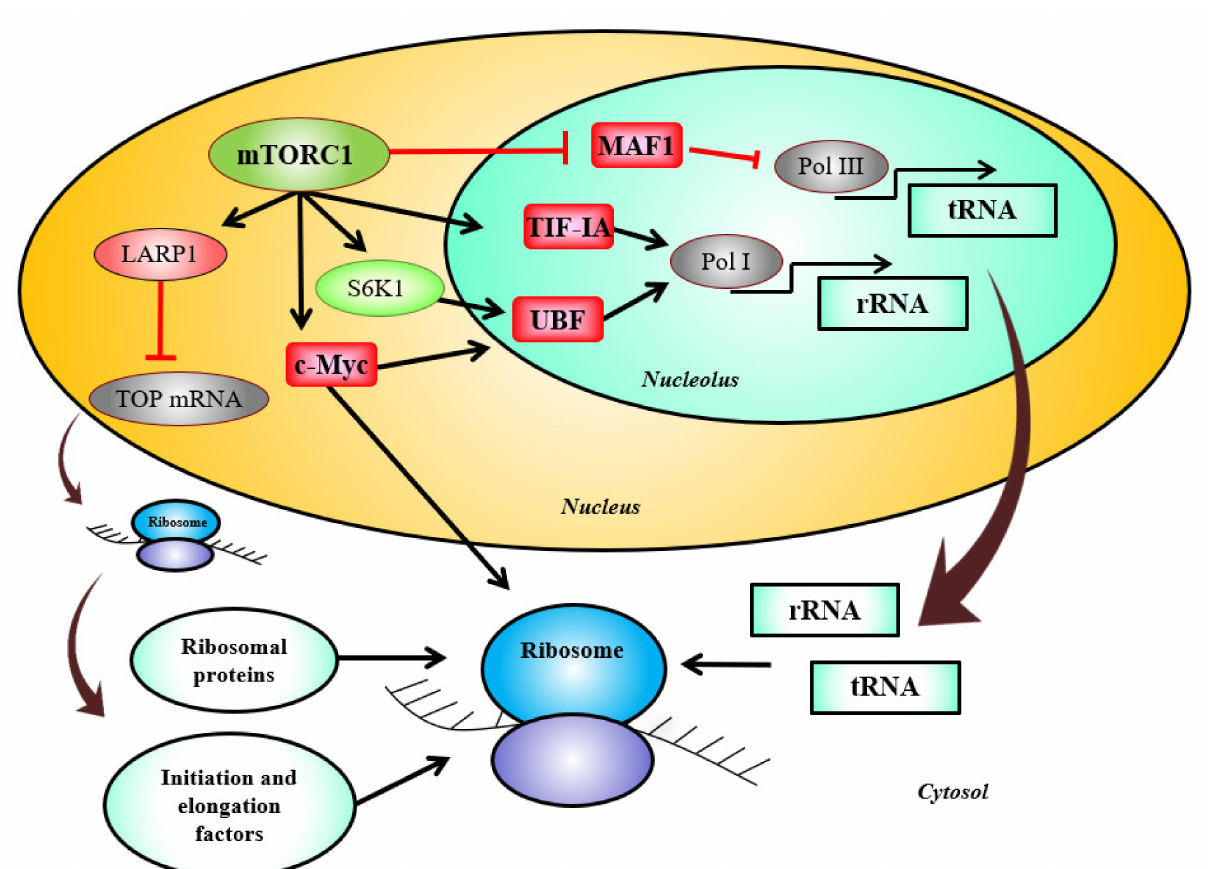
Figure 2. mTORC1 stimulates ribosome biogenesis. mTOR (mechanistic/mammalian target of rapamycin) modulates the activity of TIF-1A(transcription initiation factor IA) involved in pre-ribosomal RNA synthesis and of the ubiquitous transcription factor c-Myc that controls genes products involved in the transcription and processing of rRNA, in the protein components synthesis, and in the nuclear export of ribosomal subunits. mTOR phosphorylates MAF1 leading to inhibition of RNA Pol III (RNA polymerase III) repression function, allowing transfer RNA (tRNA) synthesis. mTORC1 (mechanistic/mammalian target of rapamycin complex 1) interacts with the RNA binding protein LARP1 (La-related protein 1), involved in TOP (terminal oligopyrimidine) mRNAs translation, and subsequently regulates the production of ribosomal proteins and initiation and elongation factors. S6K1 (S6 kinase 1), a master substrate of mTORC1, stimulates RNA Pol I (RNA polymerase I) through activation of UBF (upstream binding